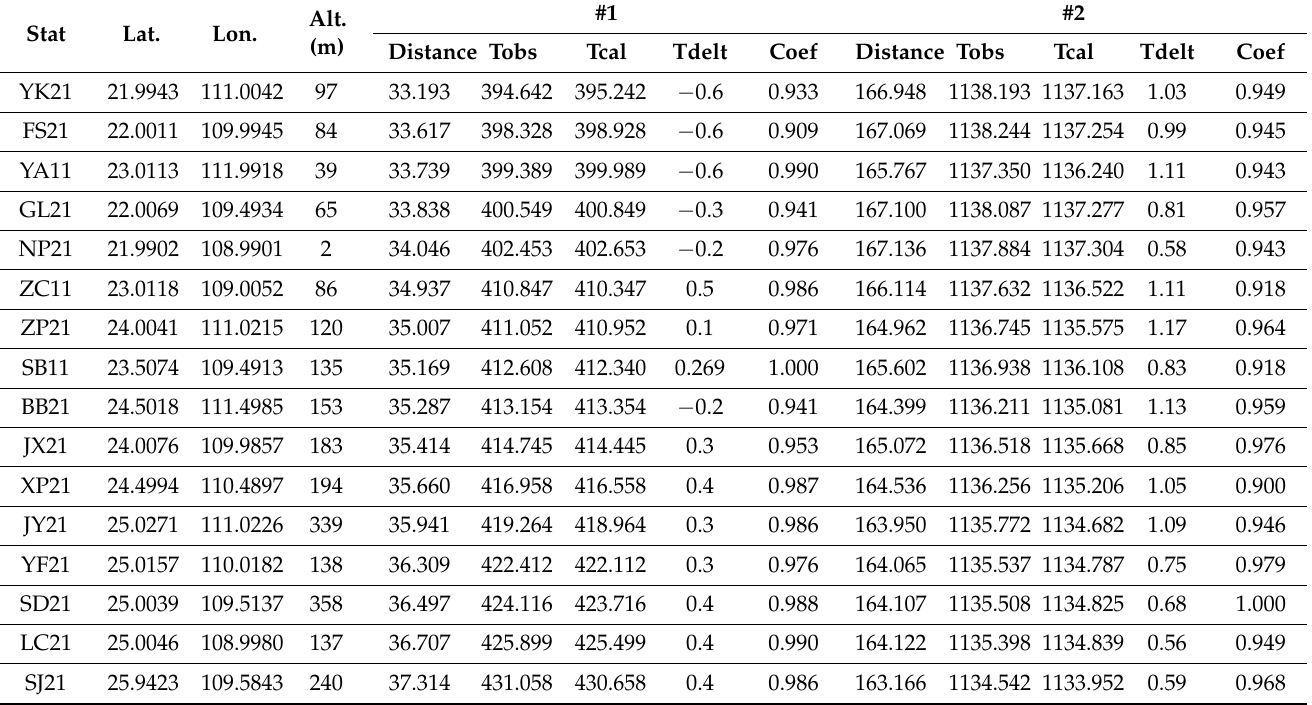
Table 3. Relative travel time difference and correlation